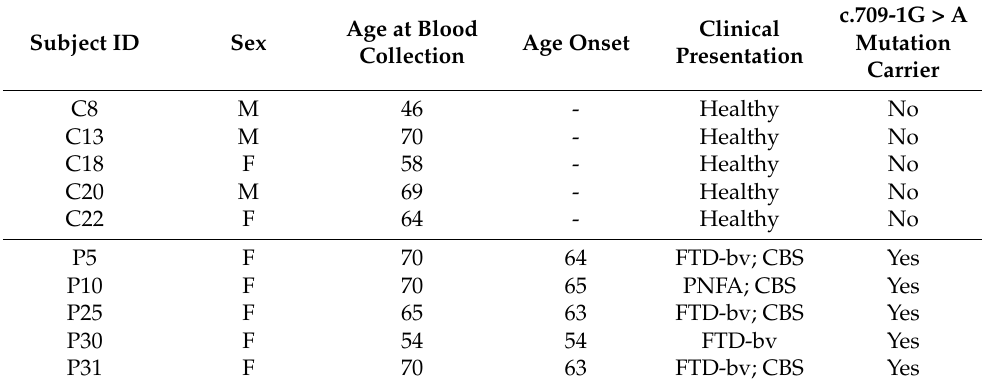
Table 1. Demographic characteristics of the lymphoblastic cell lines